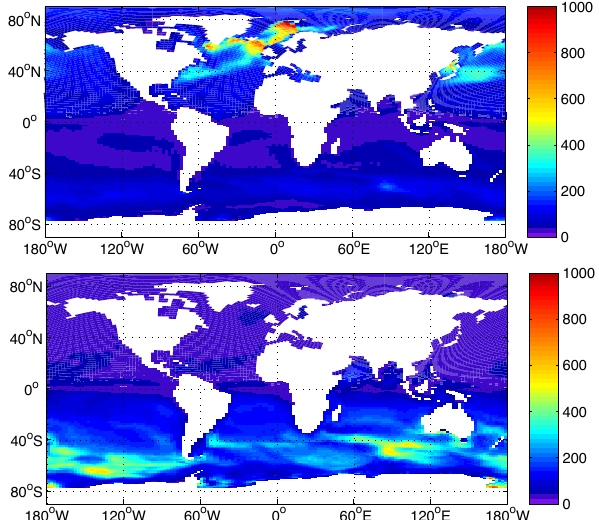
Fig. 7. Simulated mean (1978–2007) March (top) and August (bot- tom) mixed layer depths in m.